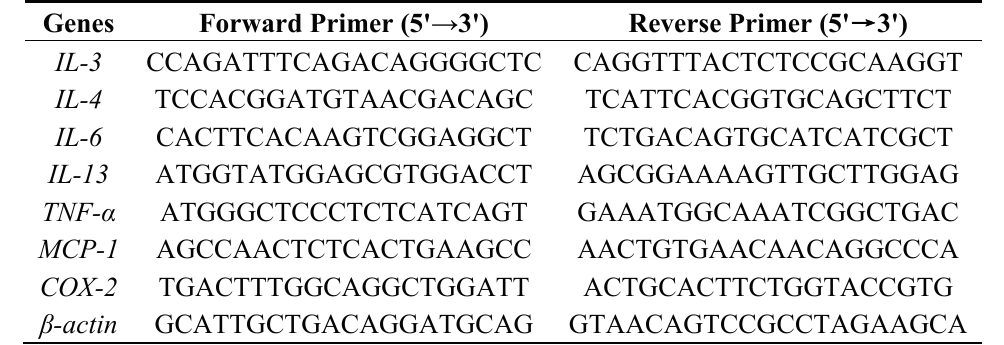
Table 1. Primers for quantification PCR of pro-inflammatory cytokine mRNAs in RBL-2H3 cells.